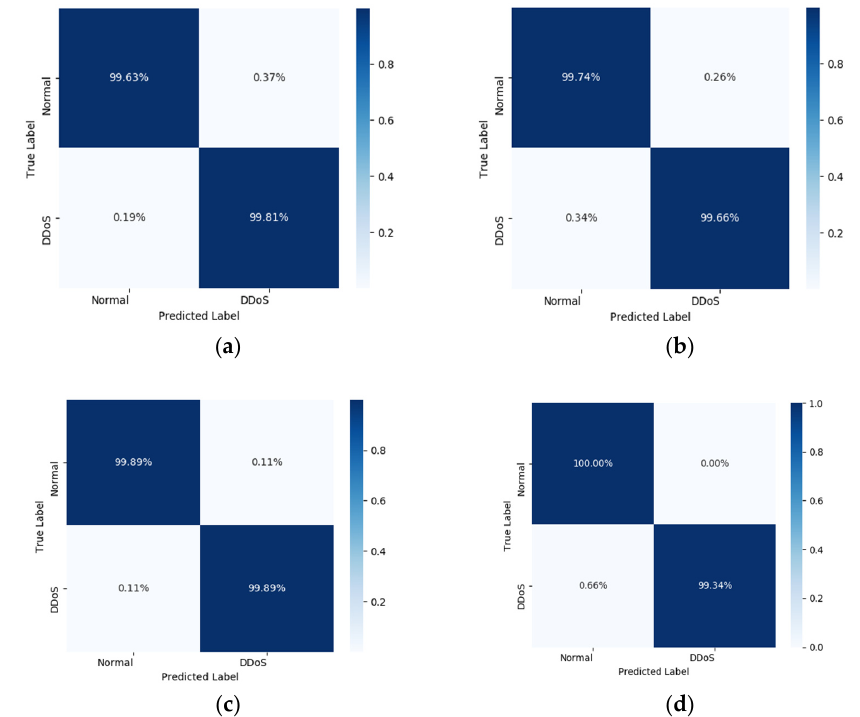
Figure 10. Comparison plot of the confusion matrix, ( a ) CNN 12 subset of features in InSDN; ( b ) CNN-LSTM 12 feature subset in InSDN; ( c ) CNN-ELM 12 subset of features in InSDN; ( d ) CNN- SVM 12 subset of features in InSDN.